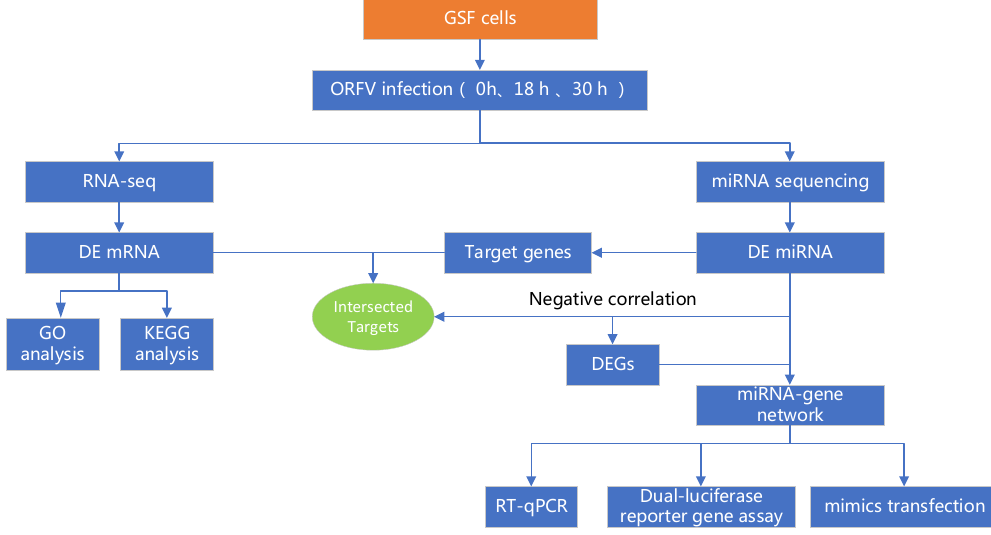
Figure 1. Flow chart of the present study.